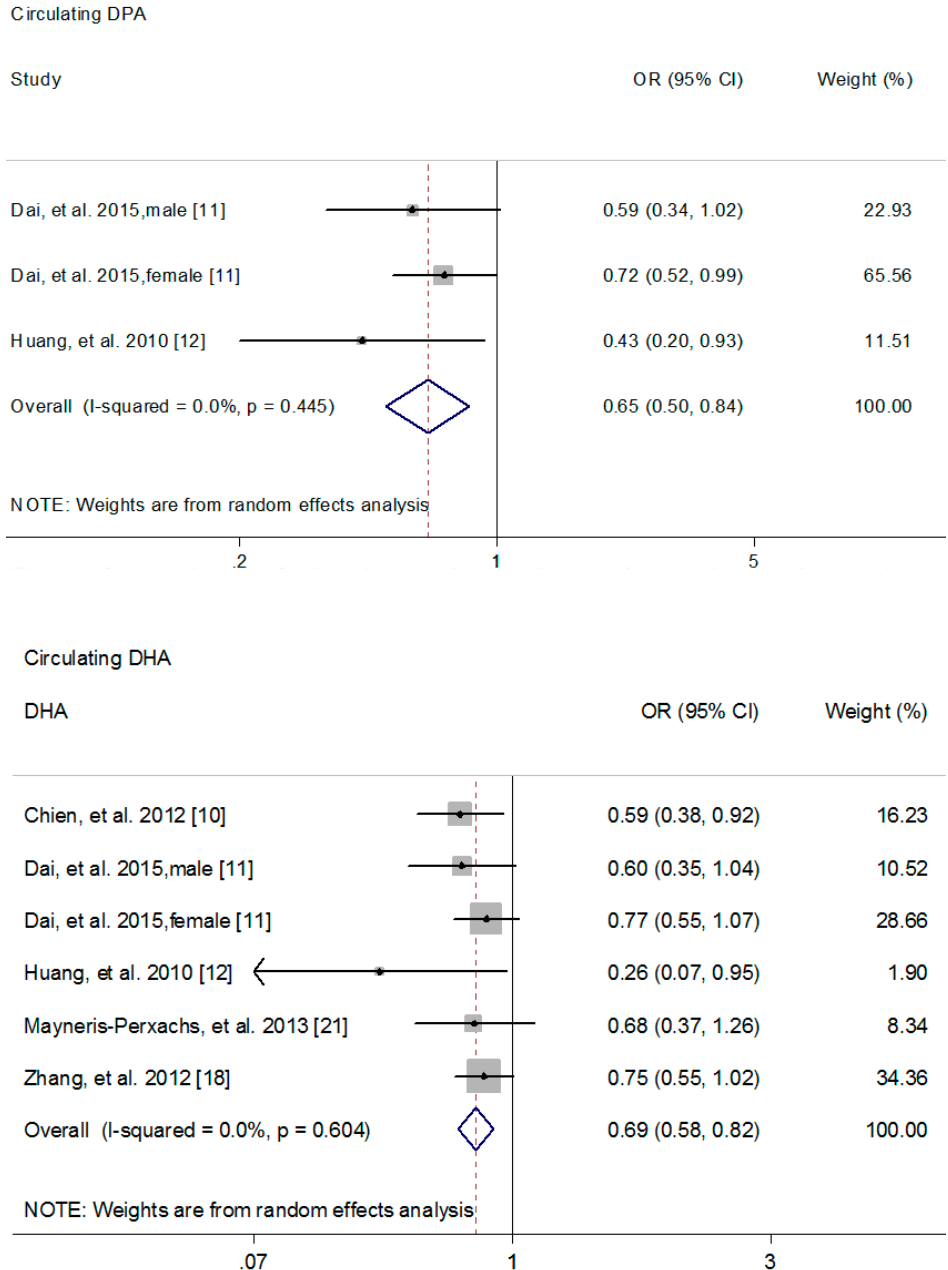
Figure 3. Forest plot to quantify the association of circulating DPA or DHA with metabolic syndrome risk. The pooled ORs were calculated by using a random-effects model for the highest versus lowest category. The diamonds denote summary risk estimate, and horizontal lines represent 95% CI.